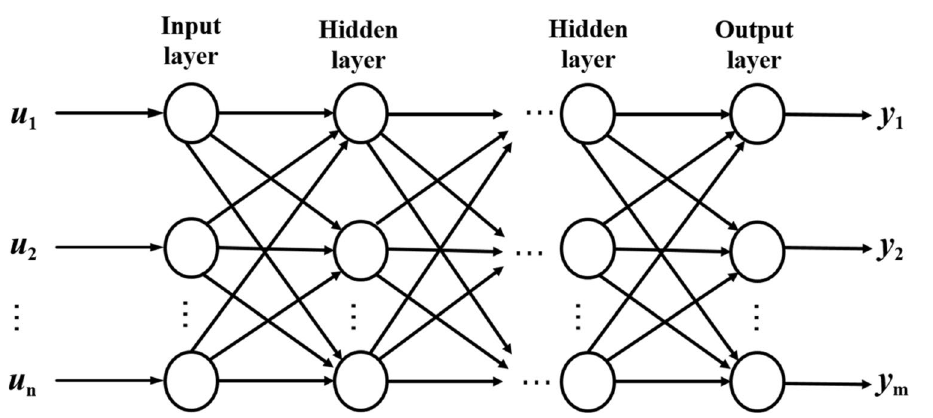
Figure 4. Multilayer perceptron neural network